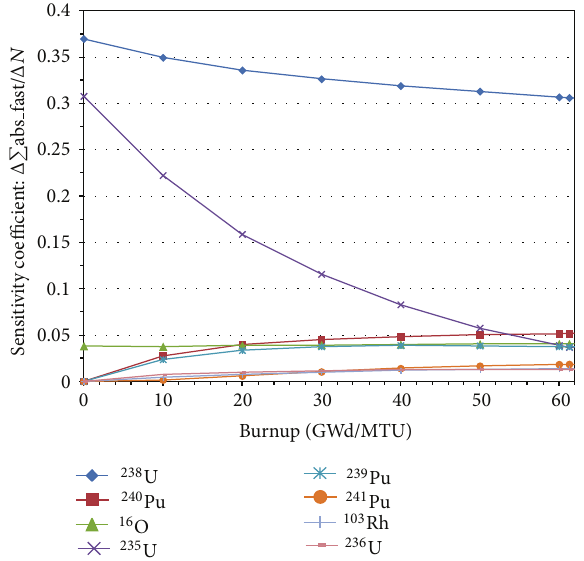
F 8: Sensitivity coefficients calculated with SCALE6.1/TRI-